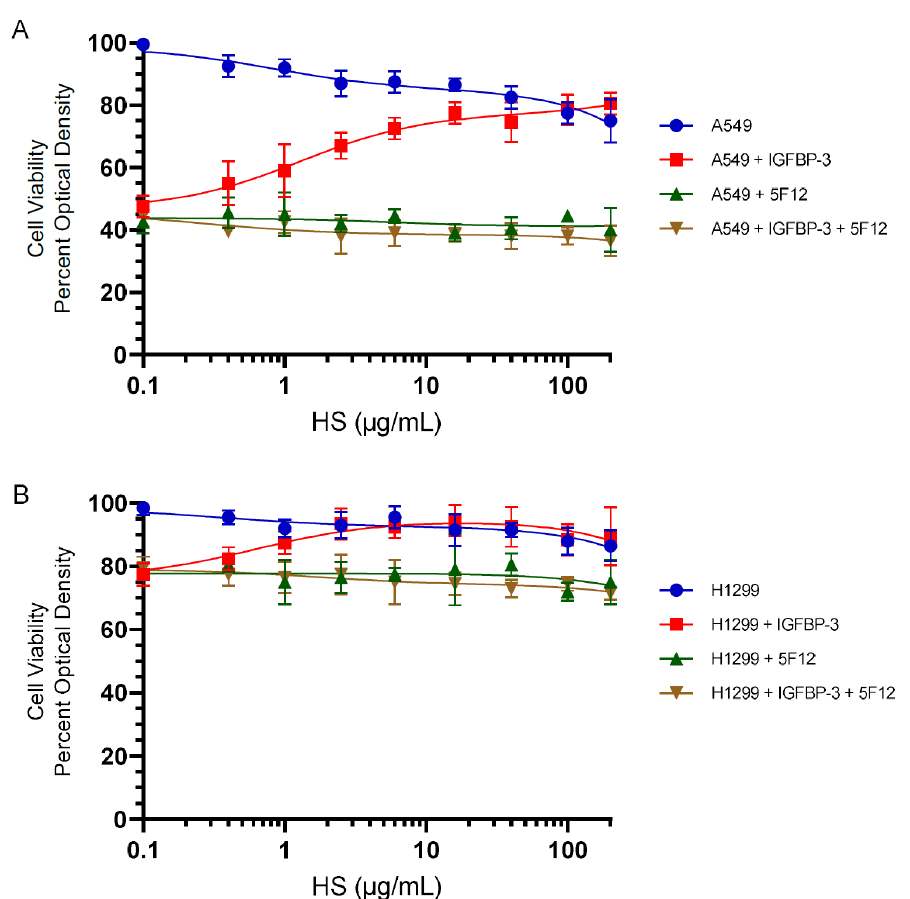
Figure 4. HS blocked the cytotoxic effects of IGFBP-3 but not upon inhibition of HA–CD44 signaling with the 5F12 antibody. Cells were seeded in 96-well plates at 0.2 × 10 5 cells per well in 10% FBS- supplemented media. The following day, the cell monolayers were incubated in serum-free medium for 24 h. Fresh serum-free media was then added and the cells were treated for 72 h with the IGFBP-3 protein (50 nM), the CD44 antibody (5F12, 5 µ g/mL) added either separately or 2 h prior to addition of IGFBP-3, or in combination, without or with increasing HS concentrations. Cell viability of A549 ( A ) and H1299 ( B ) was then assessed by the MTT assay as described in the Materials and Methods section. Optical density measurements (570 nm) were normalized by expressing each point in relation to the best-fitted Emax value of cells without added IGFBP-3 or 5F12 (set to 100%). The data were then plotted as a function of increasing HS concentrations. Using the GraphPad Prism 9.4.1 software, the data were analyzed with a nonlinear regression curve fitting approach then expressed as the mean ± S.D. of three independent experiments, each carried out in